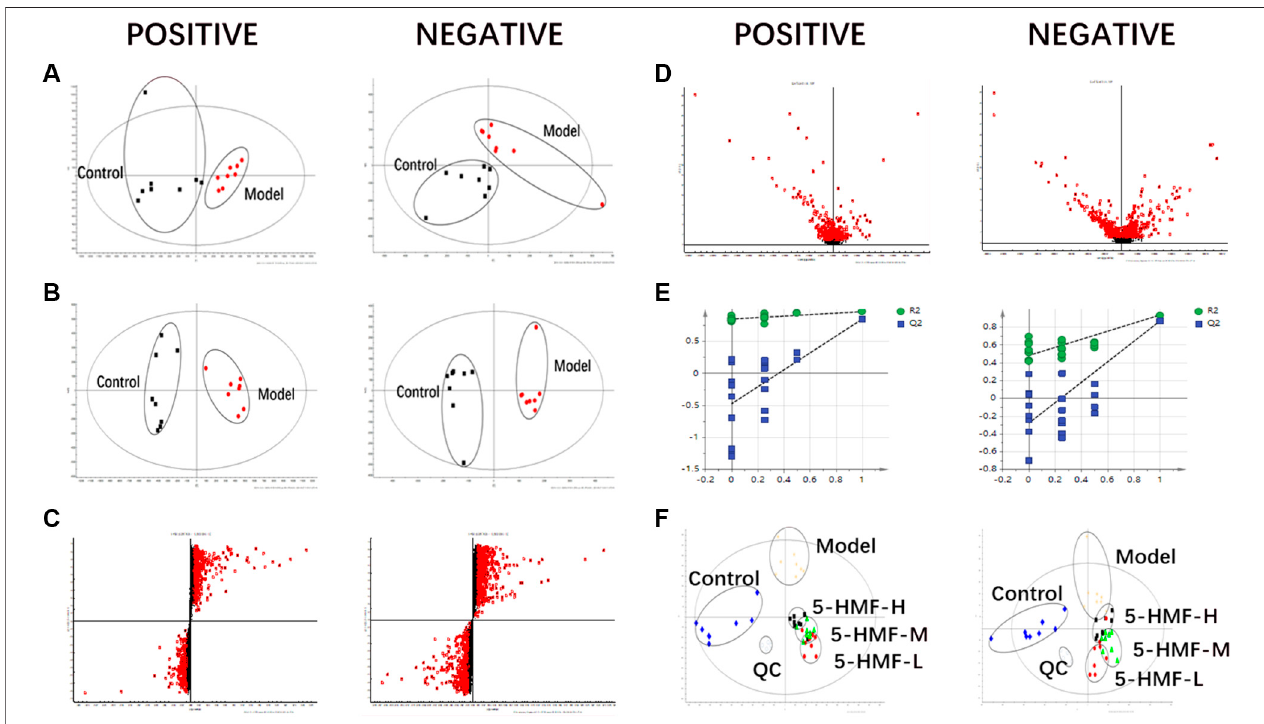
FIGURE 6| Multivariate data ofUPLC-MS/MS: (A) Principal Component Analysis Score Chart, (B) OPLS-DA Analysis Score Chart (C) OPLS-DA S-plot Chart, (D) OPLS-DAV-plotChart (E) PartialLeastSquares-DataAnalysisModelValidationDiagram, (F) PLS-DAAnalysisScoreDiagram. Plasmasampleswerecollectedfromthe different